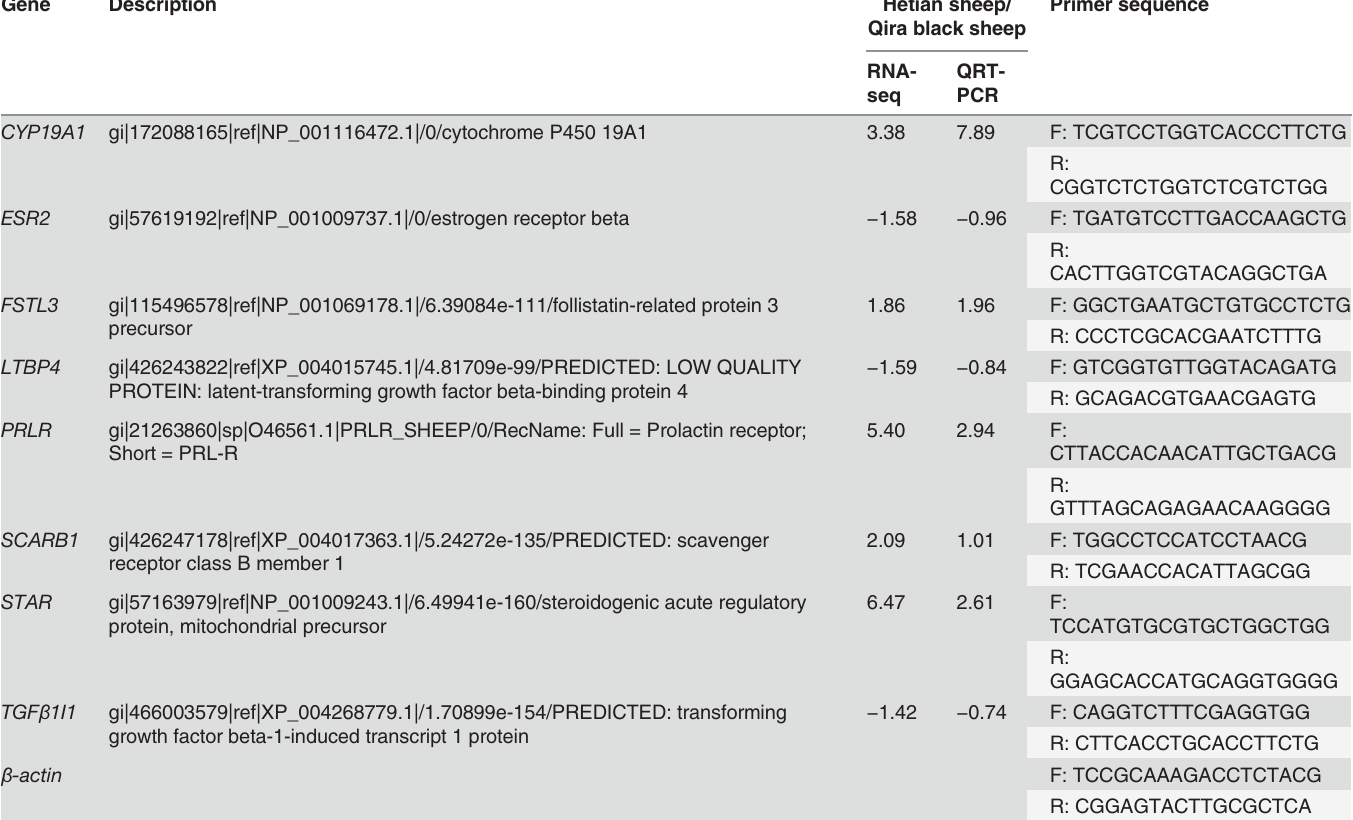
Table 4. Validation of selected RNA-seq based gene expression by real-time RT-PCR analysis. Gene